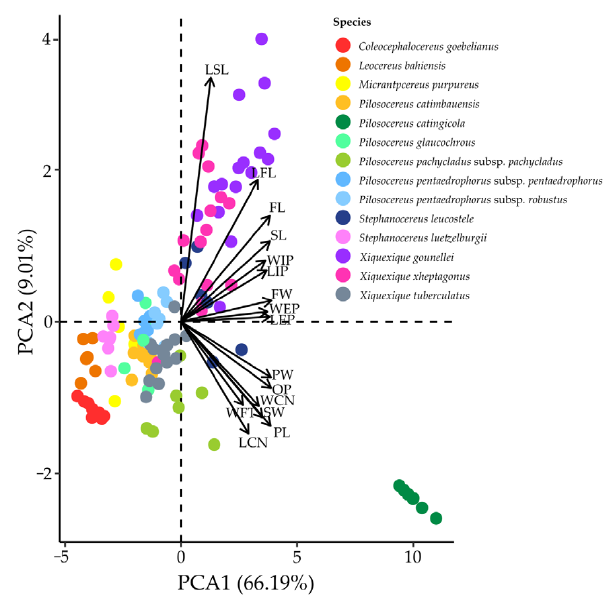
Figure 3. Principal Component Analysis (PCA) related to floral morphological characteristics of taxa from Cereinae for floral attributes associated with bat pollination. The abbreviations for each of the 17 measured variables of floral morphology are presented in Table 2. Table 4. Centered correlation of traits of Cereinae with floral attributes associated with bat pollination and axes of principal component analysis (PCA; standardized eigenvectors